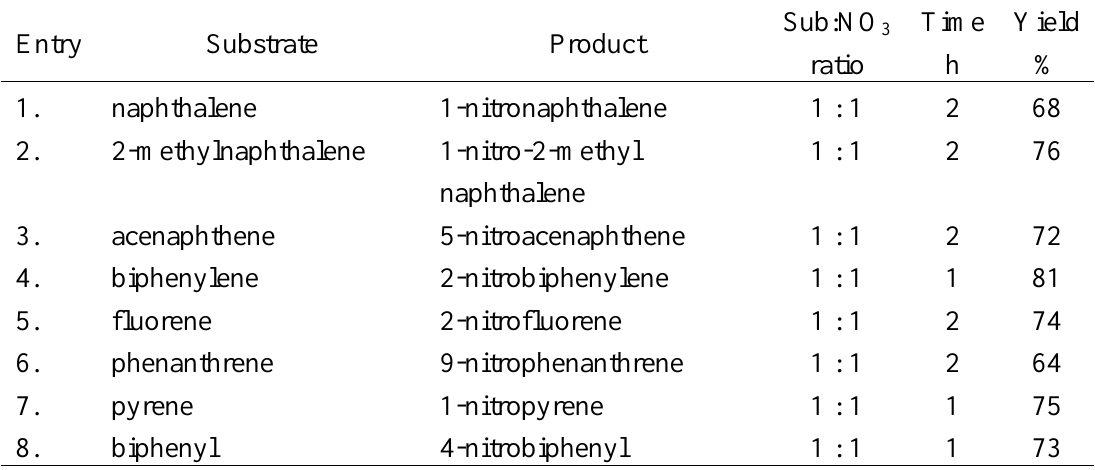
Table 2. Nitration of Polycyclic Aromatics with Bismuth